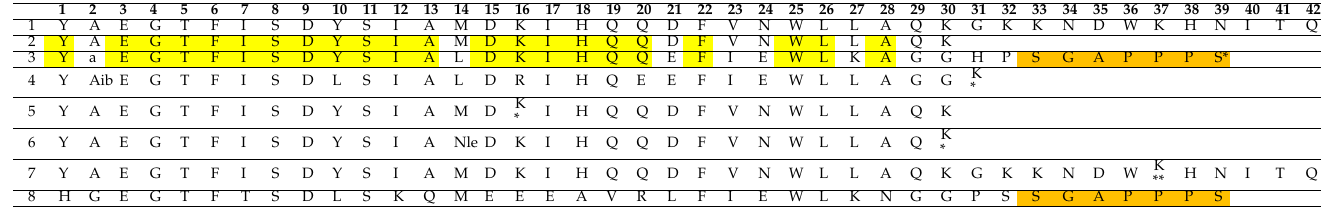
Table 1. Sequence alignment of native GIP(1-42) ligand, exendin-4, C803-GIP, and various other analogs, which previously have been used for GIPR imaging studies. C803-GIP is based on the hGIP(1-30) sequence and incorporates eight amino acid residue substitutions unique to C803-GIP. It is also amended with nine more amino acid residues, seven of which correspond to the exendin-4 sequence. The residues conserved from hGIP(1-30) are highlighted in yellow, the residues conserved from exendin-4 are highlighted in orange, the residues conserved from both hGIP(1-30) and exendin-4 are highlighted in blue, and the residues unique to C803-GIP are not highlighted.